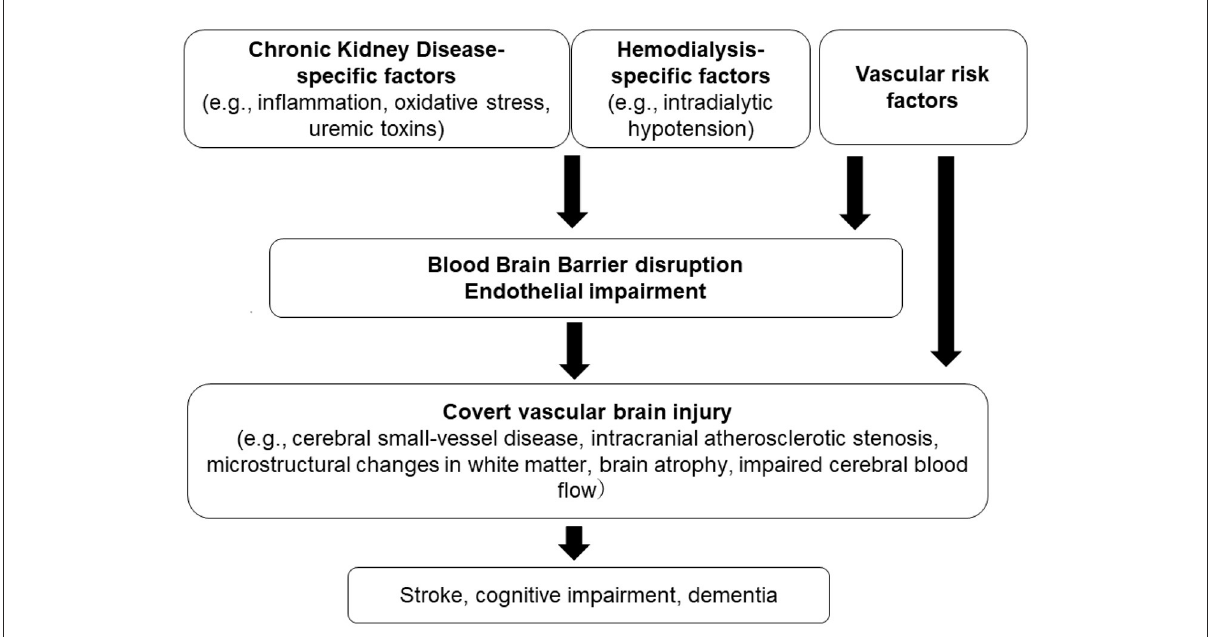
FIGURE1 Proposed pathophysiology of chronic kidney disease–related covert brain